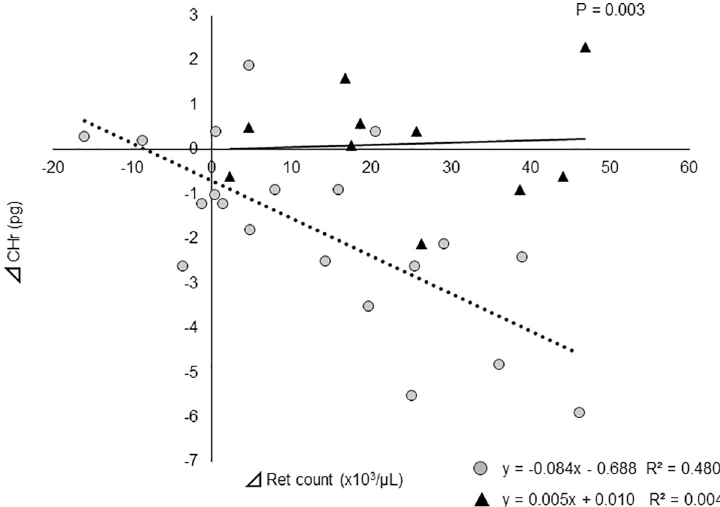
Fig 4. Correlation between the change in CHr level and change in reticulocyte count from Day 0 to Day 28. Change in CHr level showed a strong negative correlation with change in reticulocyte count in the low group (s- ft < 81.6 ng/mL) (p < 0.001) but showed no correlation in the high group (s-ft � 81.6 ng/mL) (p = 0.868). The slopes obtained by the linear regression analysis showed a significant difference between the two groups (p = 0.003). https://doi.org/10.1371/journal.pone.0252439.g004 correlation between hematopoiesis and iron status. Ret cells are differentiated erythroblasts immediately after hemoglobulin synthesis. They stay within the bone marrow for 2–3 days and then enter the circulation where their maturation completes within 1–2 days. Thus, CHr level is considered to reflect the amount of iron recently used for hematopoiesis. Because CHr level is measured directly by flow cytometry based on the Ret count and Hb level, no influences other than those associated with hematopoiesis and iron metabolism are expected, and thus CHr level is thought to be more useful than s-ft level and TSAT for diagnosing iron deficiency [19, 20].